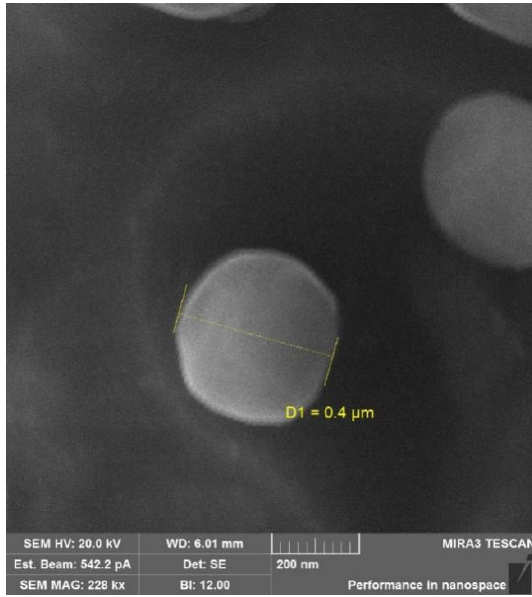
Figure 3. SEM images of the SucCS-DEX-10 particles.